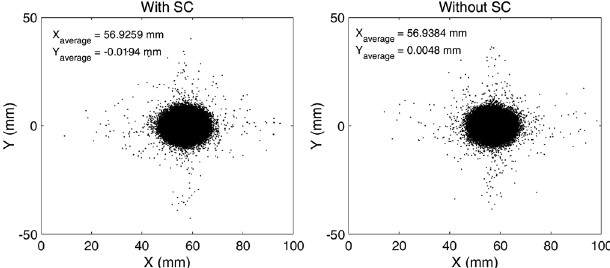
FIG. 6. Comparison of the tracking results with and without space charge. Left: The tracking result with the space charge effect. Right: The case without the space charge effect.